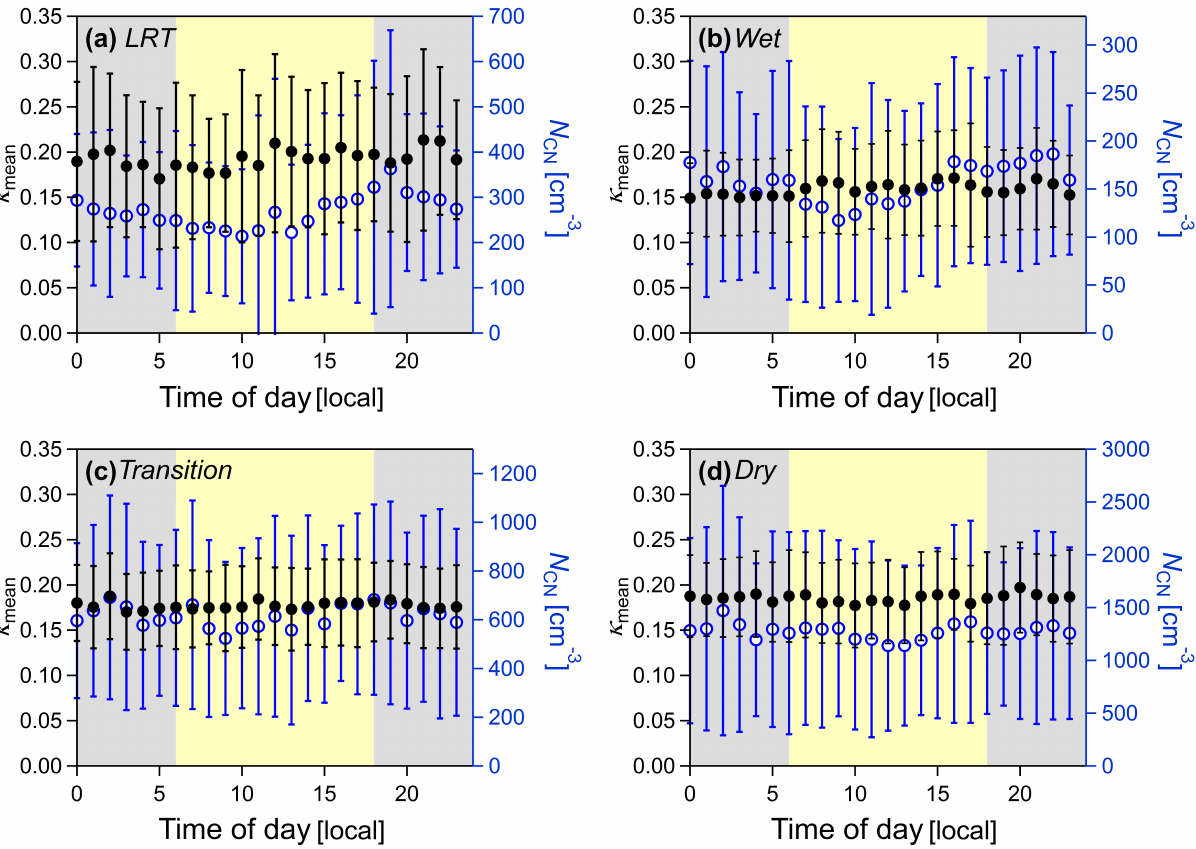
Figure 7. Diurnal cycles in hygroscopicity parameter, κ mean , and total aerosol number concentration, N CN , subdivided into seasonal periods of interest as specified in Sect. 3.3. No diurnal trend is detectable throughout the year. Note that the range of 1 standard deviation of κ mean around the mean is surprisingly small given that long seasonal time periods and data from all S levels have been averaged. The only perceptible difference is a larger scattering during a period with LRT influence (a) . Grey and yellow shading indicate night and